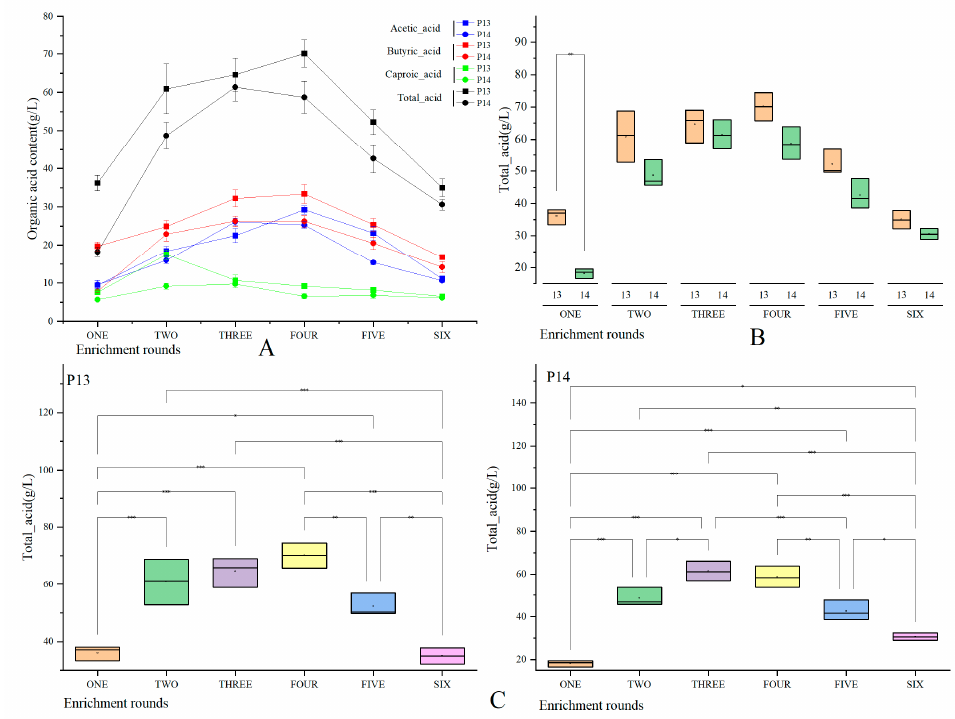
Figure 1. Organic acid content of enrichment-solution sample. ( A ) Changes in organic acids in P13 and P14 (total acids are weighted by volatile acid contents, including acetic acid, butyric acid, caproic acid, valeric acid, heptanoic acid). ( B ) Difference in total acids in EFB between heat-shock and non-heat-shock treatments in the 1st–6th rounds of enrichment period. ( C ) Difference in total acid accumulation between different enrichment cycles of P13 and P14 (more significant difference: * p ≤ 0.05; significant difference: ** p ≤ 0.01; extremely significant difference: *** p ≤